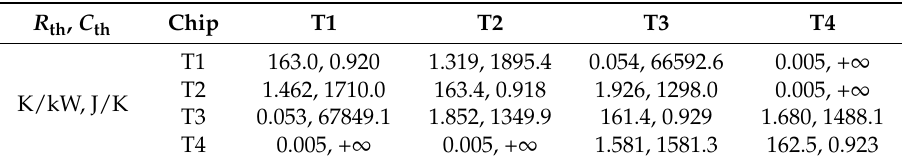
Figure 9. Extraction procedure of elements of thermal impedance matrix. Table 2. Parameters of thermal impedance matrix (n=4).